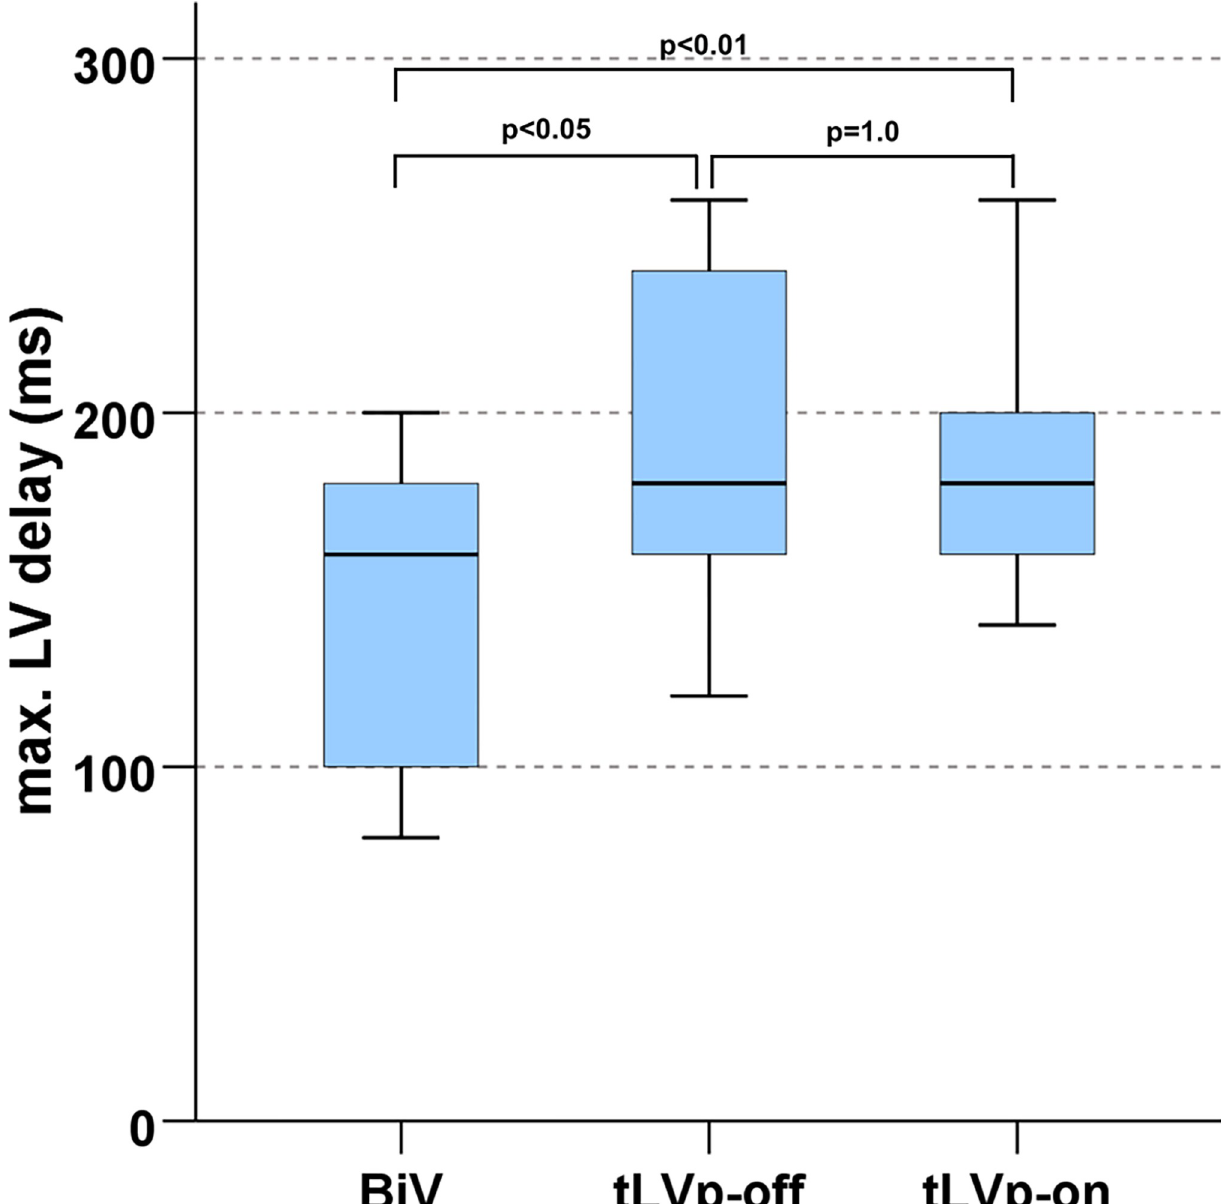
Fig 4. LV delay, measured by 2D strain (echo) in the different CRT modes. Max. (BiV–biventricular pacing, LV—left ventricle, LVEF–left ventricular ejection fraction, tLVp—triggered left ventricular